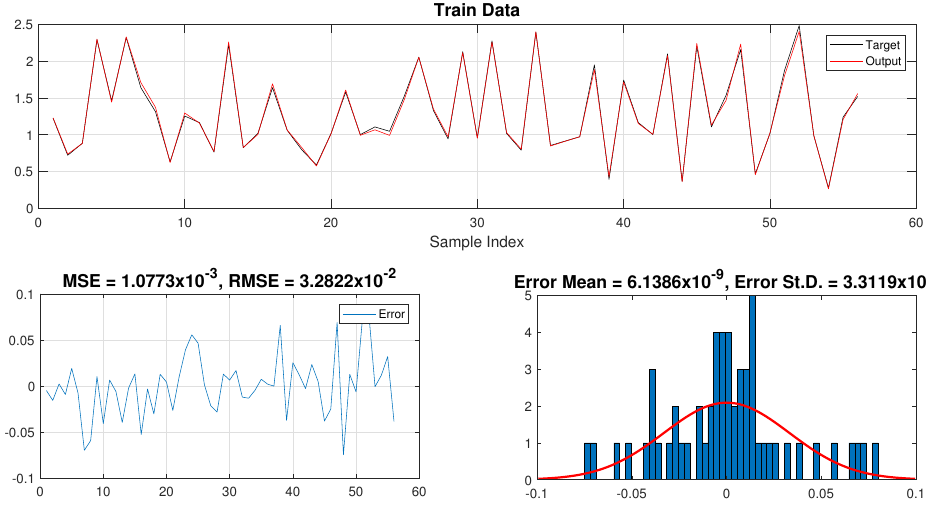
Figure 7. SISO temp–enzyme activity FIS model